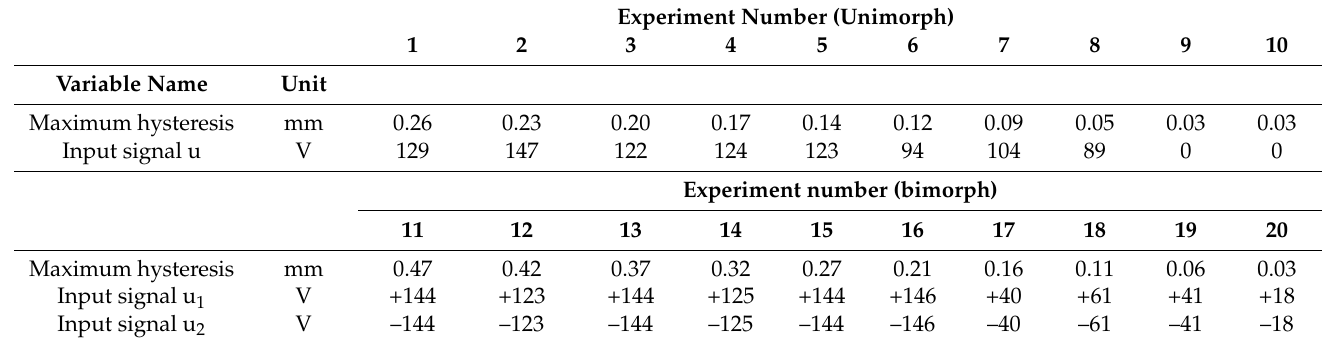
Table 4. Maximum values of hysteresis in relation to input